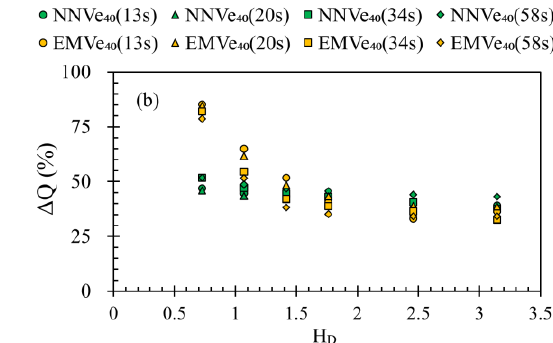
Figure 10. Relationship between wave height and embankment height ratio (H D ) and the rate of reduction of overflow volume ( Δ Q) for different hybrid structures. ( a ) Seaward vegetation type, ( b ) landward vegetation type.